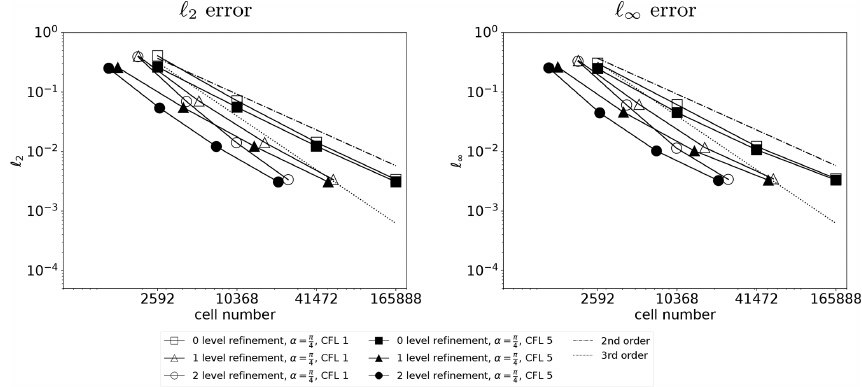
Figure 10. Convergence rate of the numerical results with respect to the number of cells in the solid body rotation test case with α = π